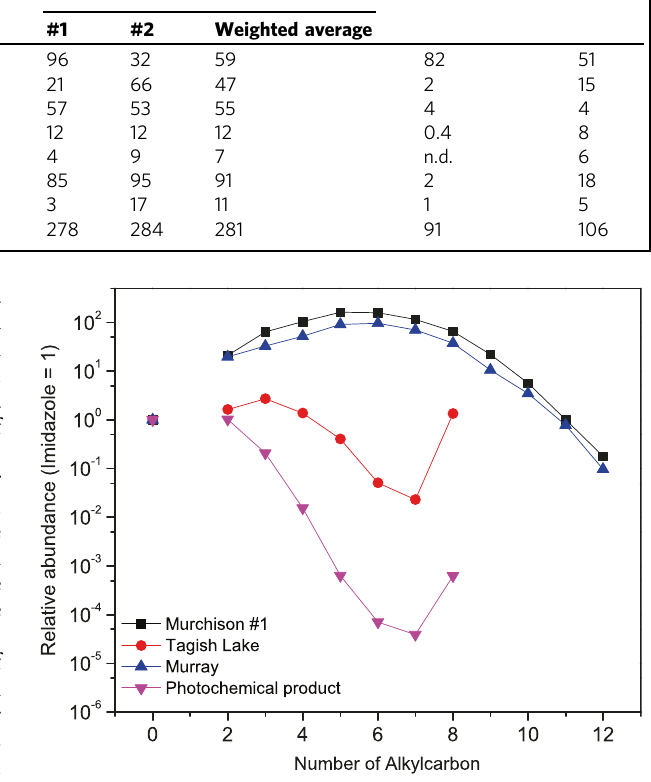
Fig. 3 Possible relative abundances of alkylated imidazole analogs. Variations in the hypothesized relative abundances of imidazole and its alkylated homologs in the Murchison #1, Tagish Lake, and Murray extracts, with relevance to the number of alkylcarbons as [(-CH 2 -) n ]. The relative abundances of these molecules in the organic residues formed by photochemical reactions of interstellar ice analogs are shown for